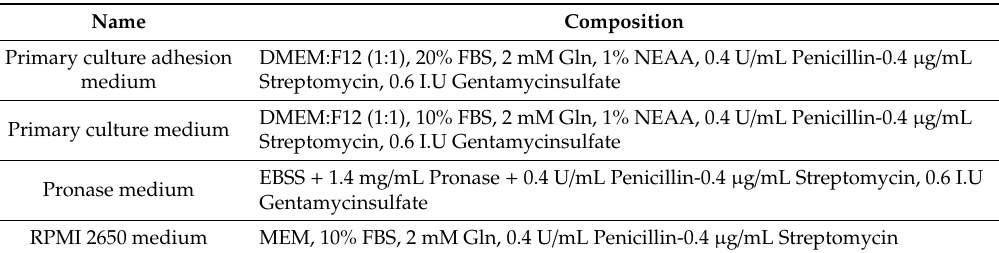
Table 1. Composition of the cultivation media used in this work. EBSS = Earle’s balanced salt solution; FBS = Foetal bovine serum; Gln = Glutamine; DMEM = Dulbecco’s modified Eagle’s medium; MEM = minimal essential